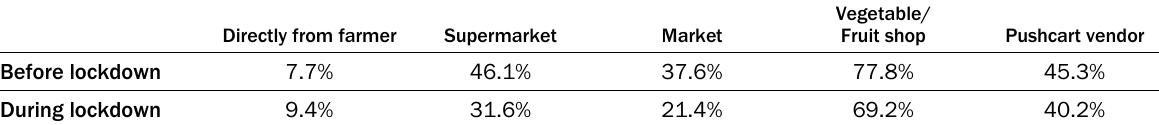
Table 2. Fresh Vegetable and Fruit Purchasing Behavior Before and During Lockdown ( N =117)